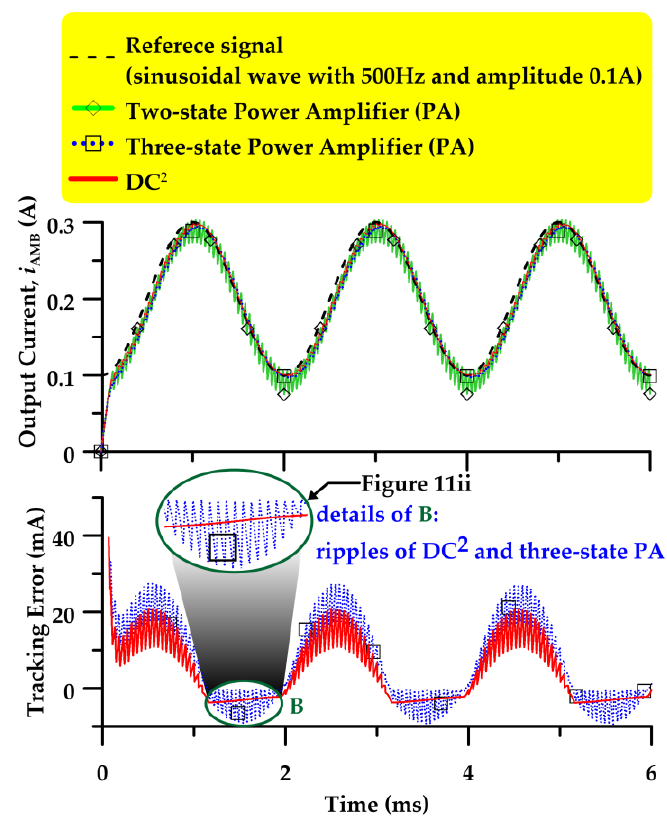
Figure 11. Output currents and tracking errors by two-state power amplifier, three-state power amplifier and DC 2 (dual cooperative drive circuit). (Reference signal: sinusoidal wave with 500 Hz and amplitude 0.1 A).